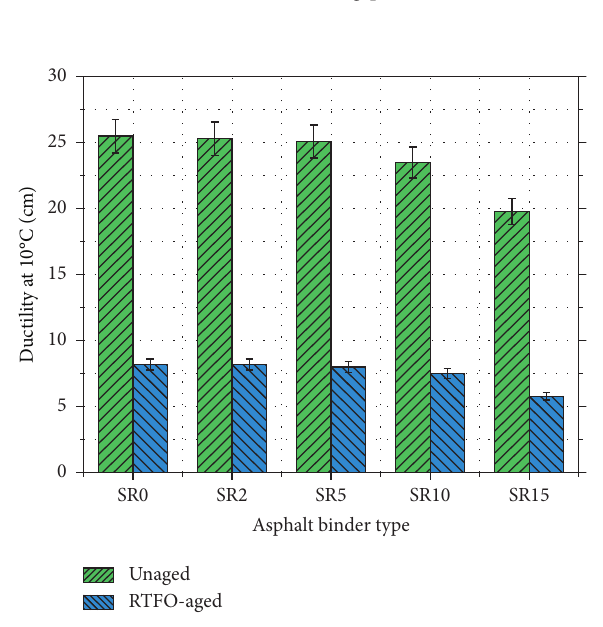
Figure 4: Ductility.